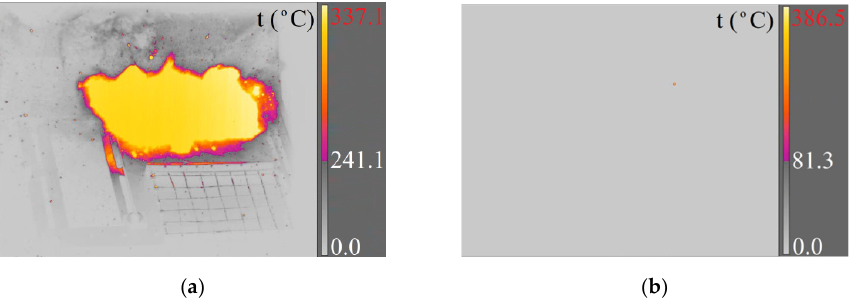
Figure 5. Registration of a 7.62 × 51T projectile fired from a 7.62 × 51 mm ballistic barrel: ( a ) X6580sc camera (220 fps); ( b ) A6901scSLS camera (1000 fps).